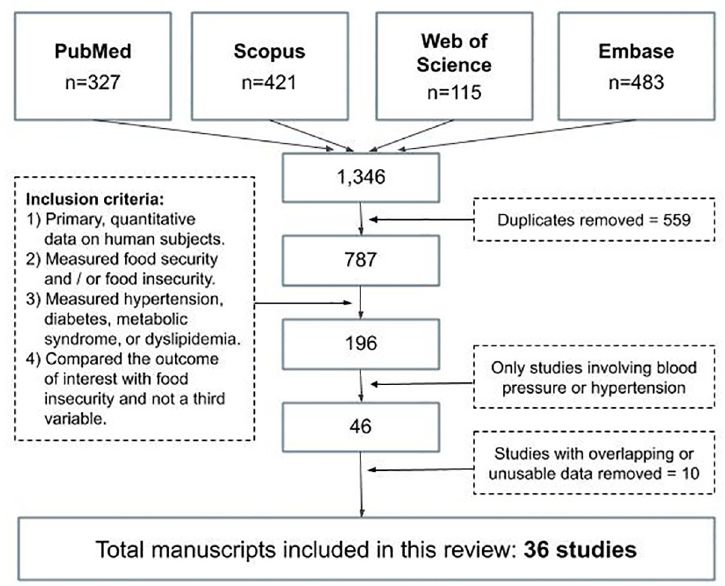
Fig 1. Flow chart summarizing the search and selection process. Presented is the search process followed by study selection leading to 36 included studies.